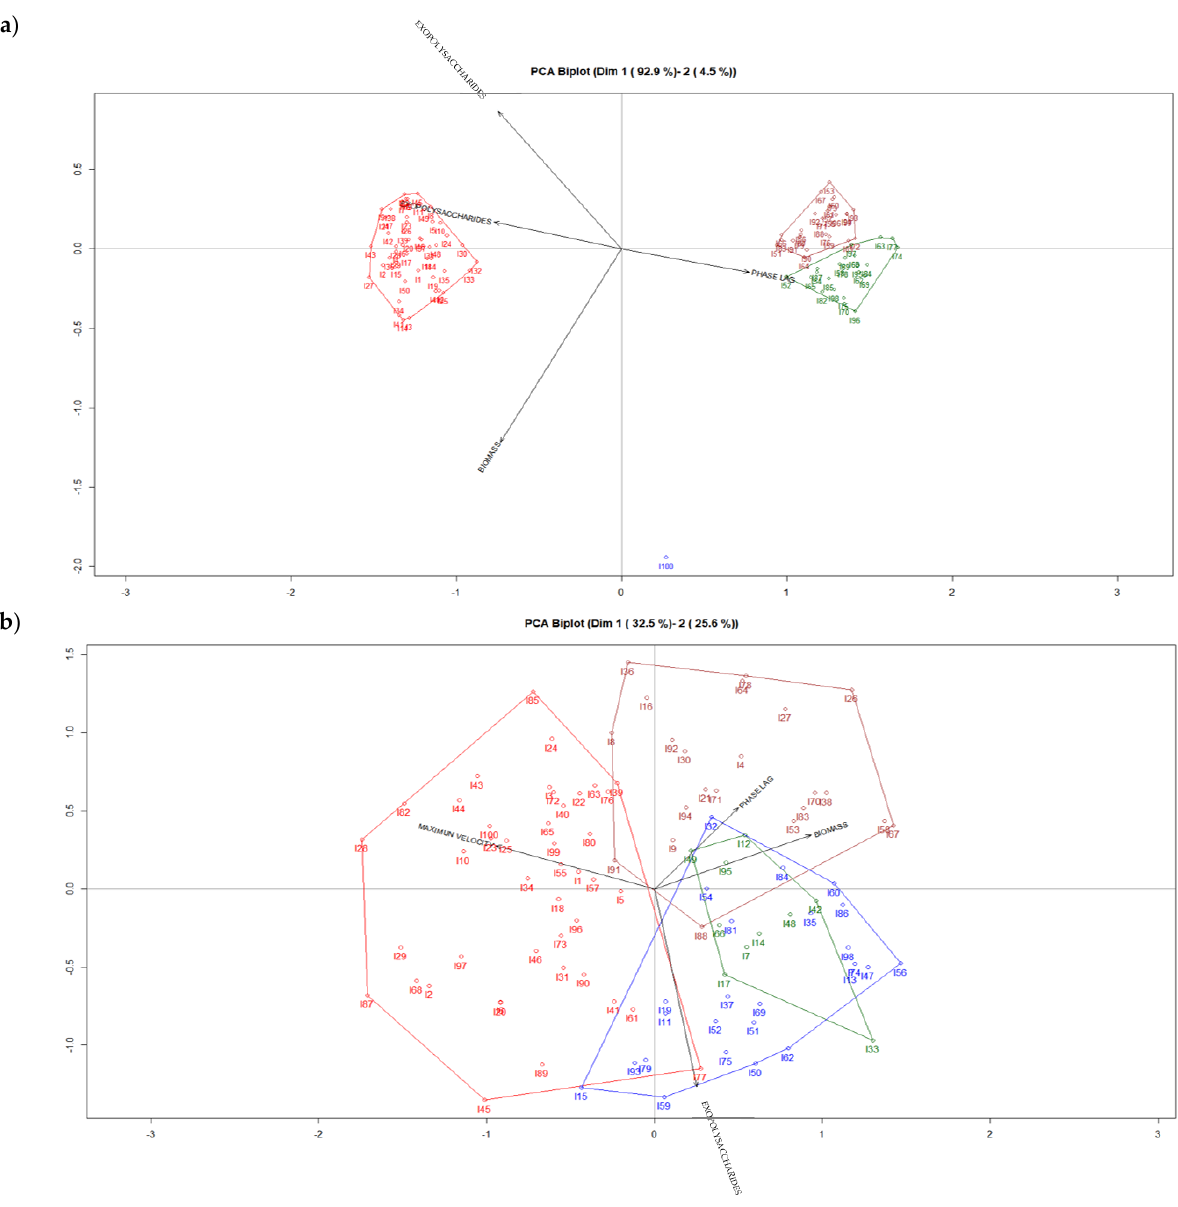
Figure 1. ( a ) PCA biplot for the mycelial and cultural characteristics of the hybrid strains of Pleurotus ostreatus cultivated on solid culture M1 and M2, and liquid culture L1 and L2, ( b ) PCA biplot for the mycelial and cultural characteristics of the hybrid strains of Pleurotus djamor cultivated on solid culture M1 and M2 and liquid culture L1 and L2.